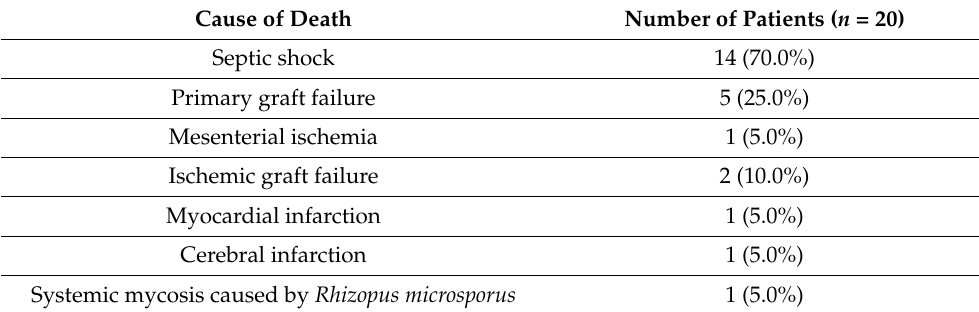
Table 3. Details about causes of death in non-surviving patients (double naming